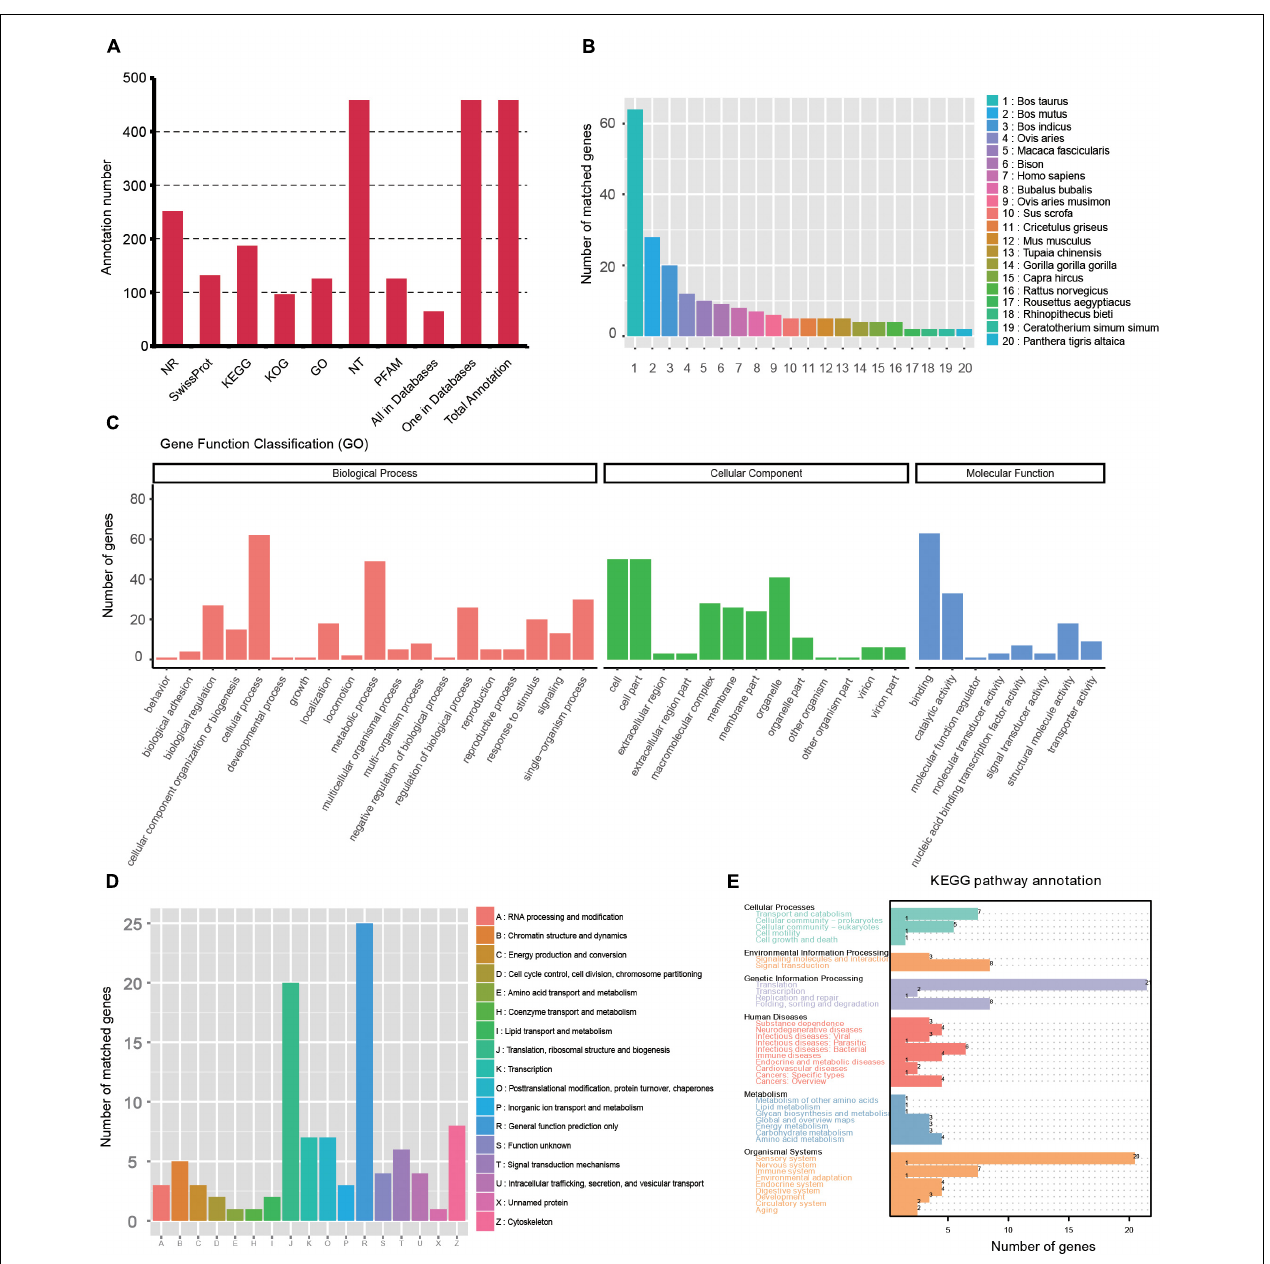
FIGURE 3 | Function annotation of novel genes. (A) Function annotation of novel genes in all databases (NR, NT, Pfam, KOG, Swiss-Prot, KEGG, and GO). (B) Nr Homologous species distribution diagram of novel genes. (C) Distribution of GO terms for all annotated transcripts in biological process, cellular component, and molecular function. (D) KOG enrichment of novel genes. (E) KEGG pathways enrichment of novel